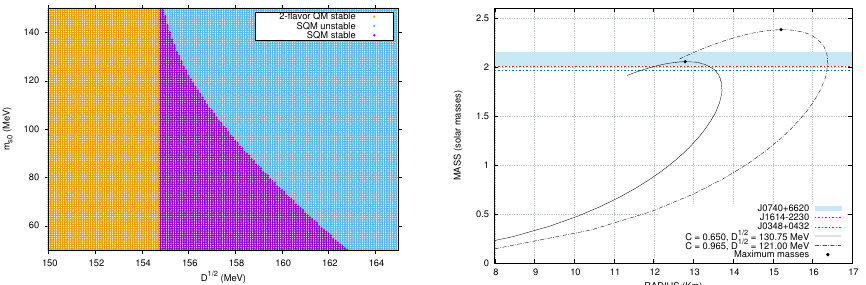
Figure 21. ( Left ) Stability window for fixed C = 0, ( Right ) mass–radius diagram for different values √ D . Figures based on the results shown in of C and